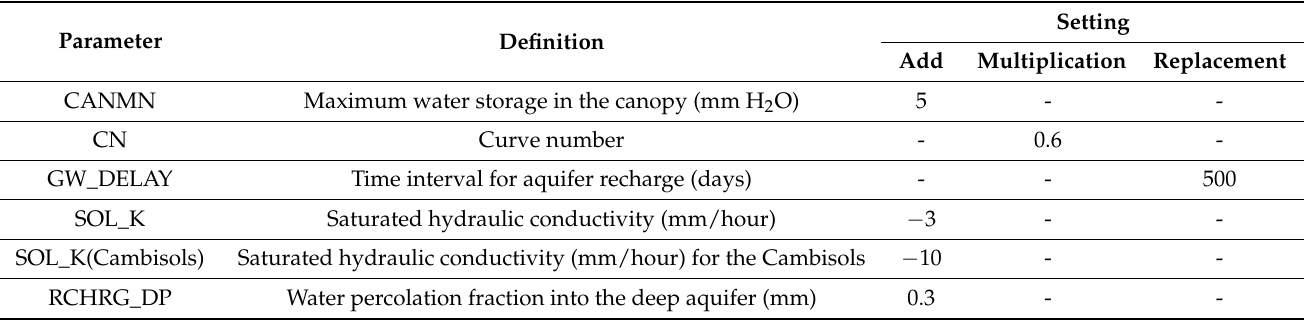
Table 4. Calibration Parameters Definition and their